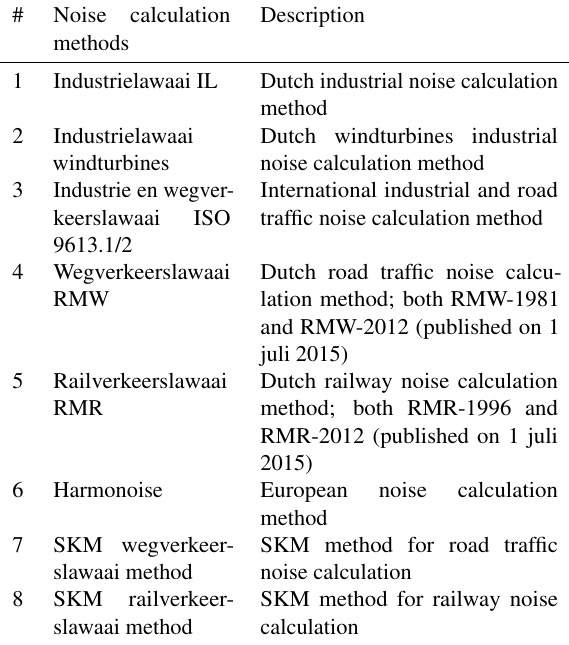
Table 1: Noise calculation methods followed in